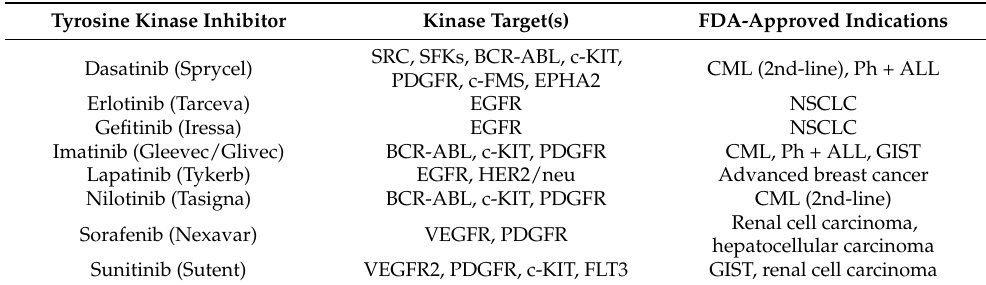
Table 2. Some tyrosine kinase inhibitors used in clinical practice. Reproduced with permission from [103]. Copyright 2010